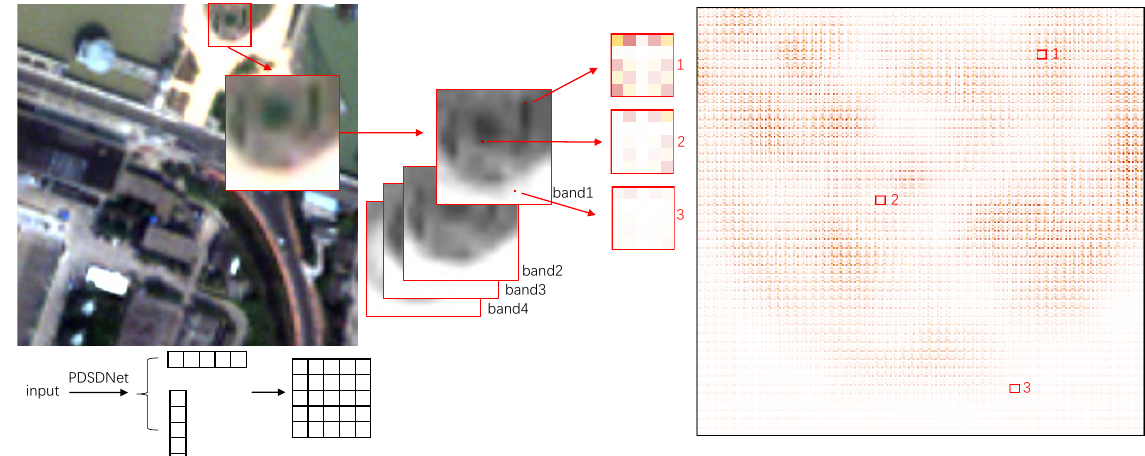
Figure 15. The heat map of the PDSDNet filters corresponding to the first row test image in Figure